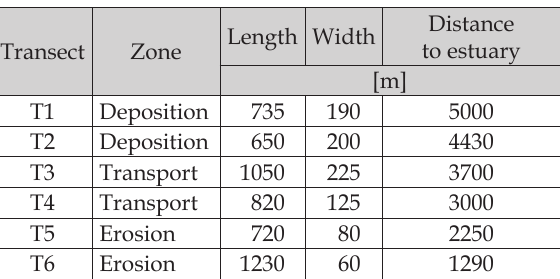
Table 1. Characteristics of the transects of the re- searched